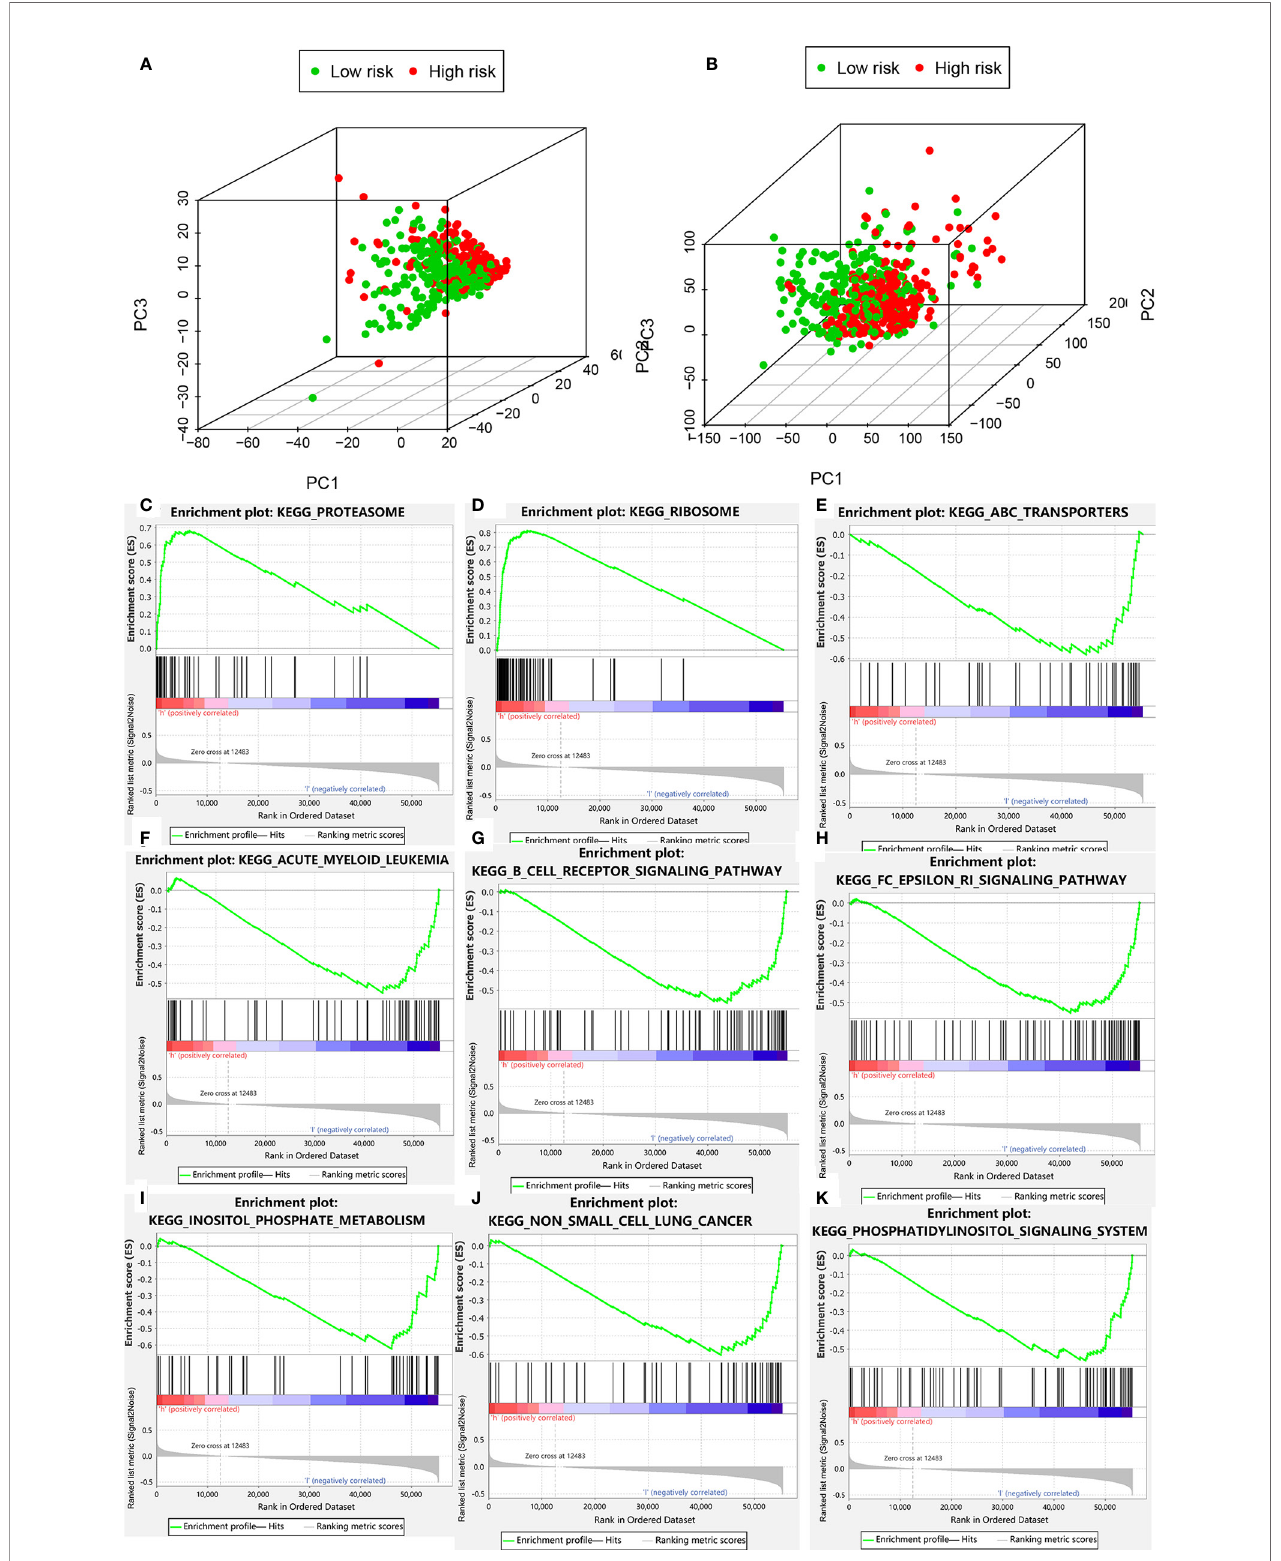
FIGURE 7 | Clustering analysis based on risk score. (A) PCA of two categories. (B) PCA for genome-wide expression pro fi les between high- and low-risk groups. (C – K) Enrichment plot for KEGG pathways